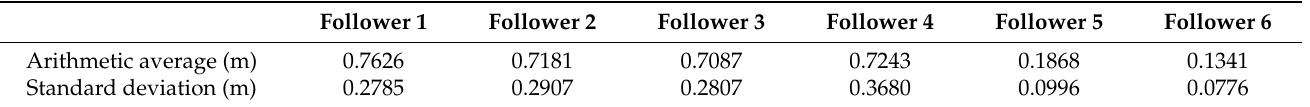
Table 3. The average distance and standard deviation between the follower and leader routes at a speed of 1.75 m/s.